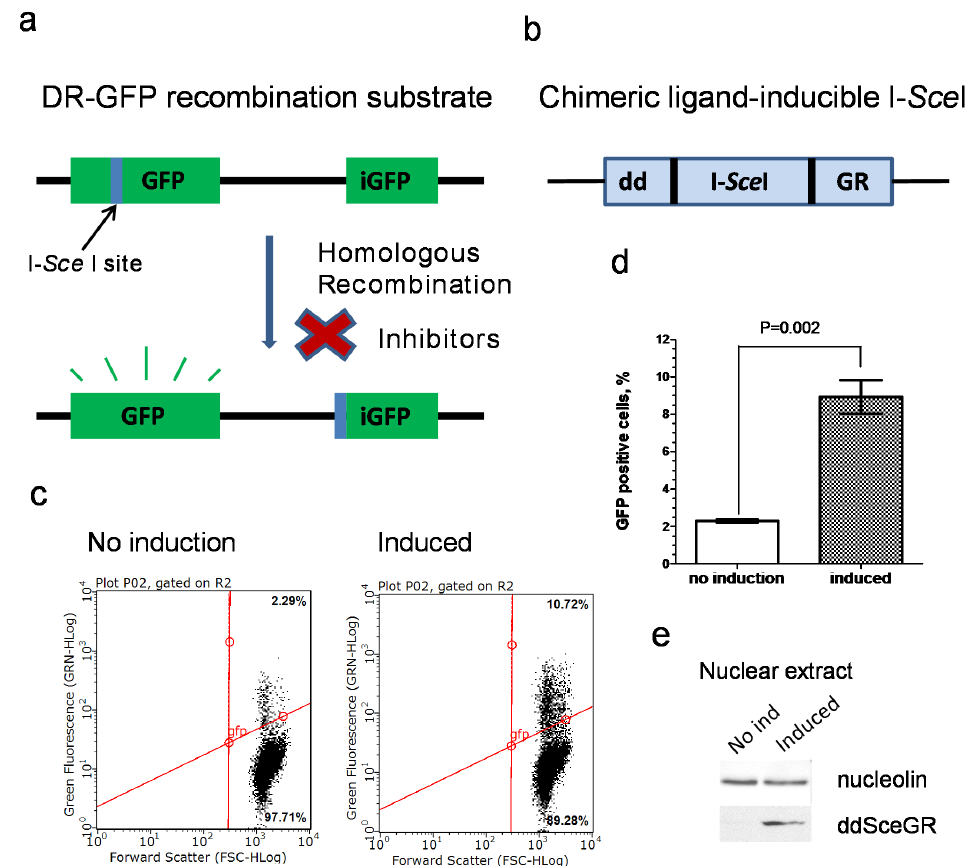
Figure 1. Development of an IndDR-GFP system. The schemes ( a ) of the DR-GFP reporter operation and ( b ) of the chromosomally integrated ligand-inducible I- Sce I. ( c ) Representative flow cytometry plots for GFP fluorescence in the DSB-induced and uninduced U-2 OS IndDR-GFP cells (clone #3). ( d ) Histogram depicting the GFP+ fractions in DSB-induced and uninduced U-2 OS IndDR-GFP cells (clone #3). ( e ) The expression level of ddSceGR in the nucleus before and after induction in U-2 OS IndDR-GFP cells (clone #3). GFP—green fluorescent protein; iGFP—internal fragment of GFP; I- Sce I— rare cutting endonuclease from S. cerevisiae; dd—destabilizing domain of FKBP12; GR—the ligand binding domain of the rat glucocorticoid receptor.